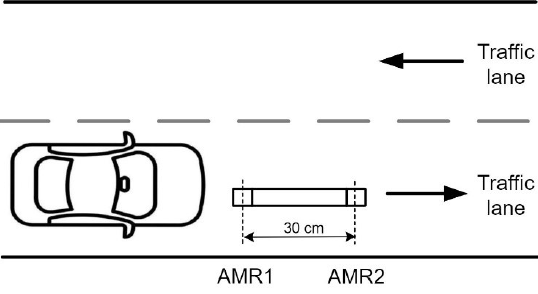
Figure 1. Experimental set-up functional view.